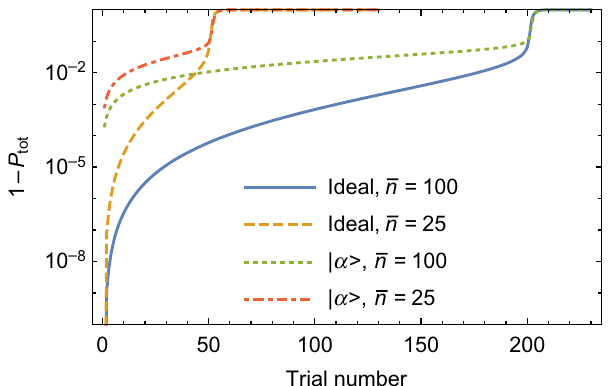
FIG. 5. One minus total probability P tot that a single field state successfully “catalyzes” a sequence of reactions taking a series of atoms in state | g (cid:2) to atomic coherent states. The initial field states have an average photon number of either approximately 100, to permit comparison with the scheme from Refs. [8,49] using coherent states, or approximately 25. The ideal initial field states found using Eq. (17) significantly outperform coherent states. The reactions maintain a 90% total success probability for 2 ¯ n